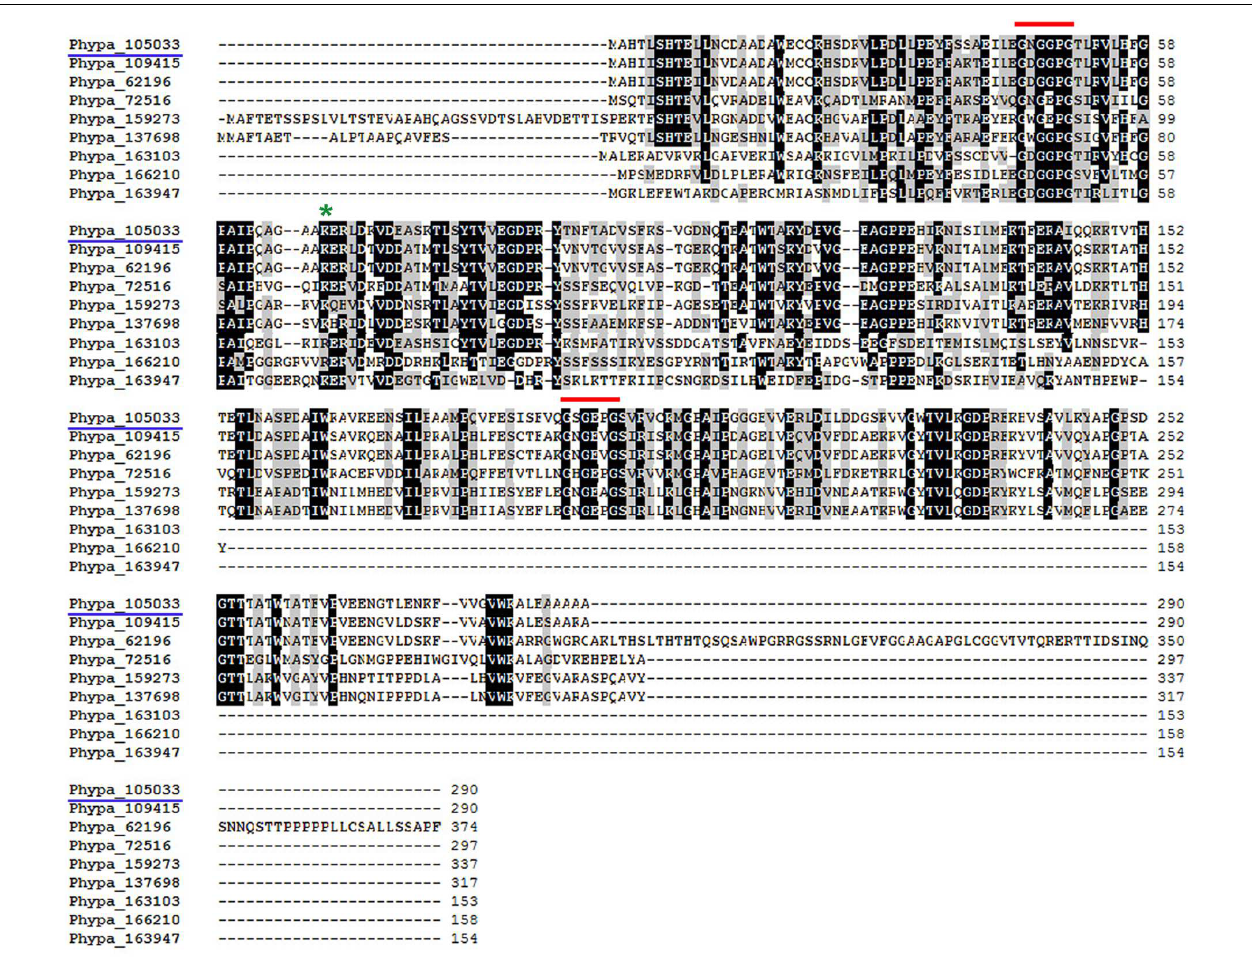
FIGURE 1 | Alignments of deduced amino acid sequences of PpPR-10 with other moss PR-10-like proteins. Alignments were performed with ClustalW. PpPR-10 (Phypa_105033) used in this study is highlighted (blue underline). Red lines and the green asterisk mark the GXGXXG motif and the conserved lysine (K68),